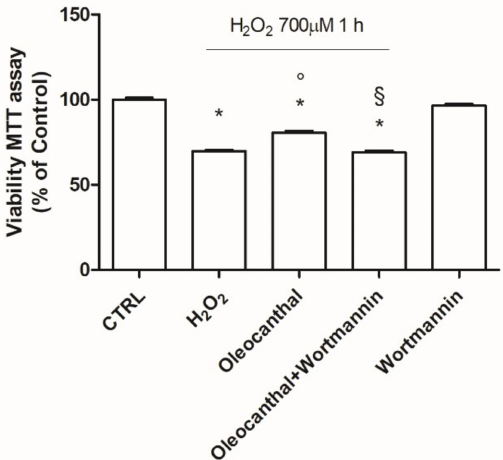
Figure 11. Effect of Akt inhibitor wortmannin on H 2 O 2 -induced injury in differentiated SH-SY5Y. Cells were treated with 10 µ M oleocanthal for 24 h in absence/presence of 100 nM wortmannin prior to peroxide exposure, then cell viability was assessed with MTT assay. Each bar represents the mean ± SEM of three independent experiments. Data were analyzed by one-way ANOVA followed by Bonferroni’s test. * p < 0.05 with respect to CTRL; ◦ p < 0.05 with respect to H 2 O 2; § p < 0.05 with respect to